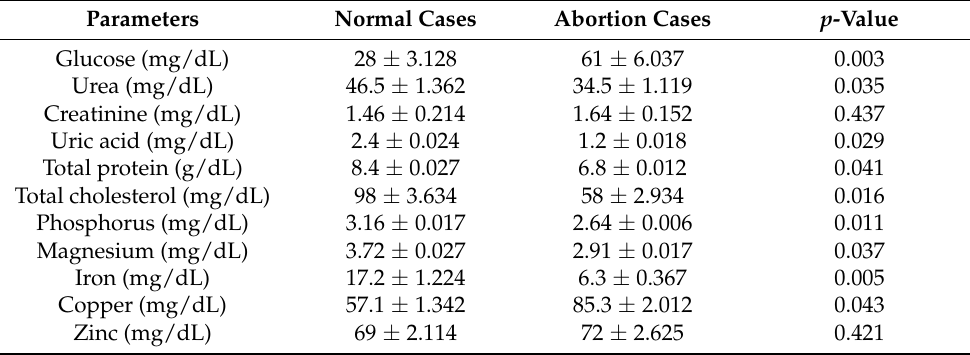
Table 4. A comparison of the mean values of various blood biochemical parameters in buffaloes presenting abortion and normal